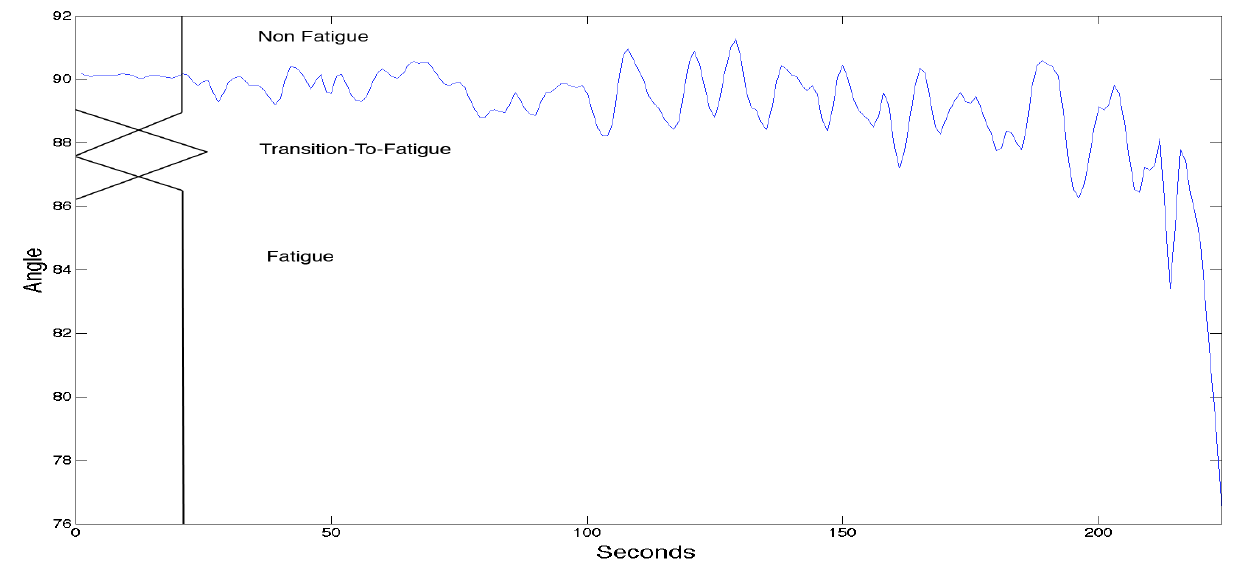
Figure 3. The use of elbow angle to label and classify the signal.